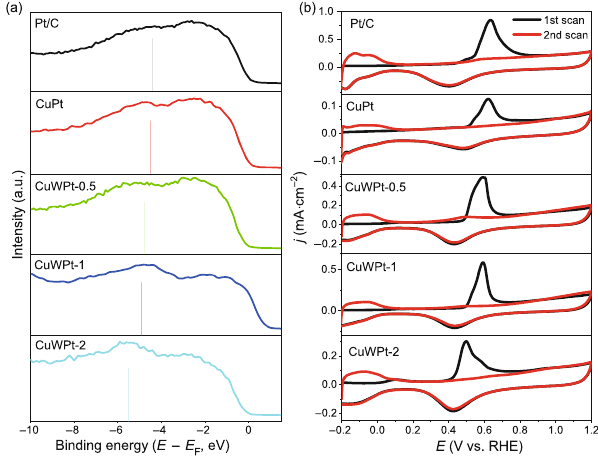
Figure 2 (a) XRD patterns of CuWPt-2, CuWPt-1, CuWPt-0.5, binary CuPt alloy nanoparticles and commercial Pt/C catalyst; (b) the correspondingly magnified XRD patterns of the selected ranges highlighted by the light blue color.